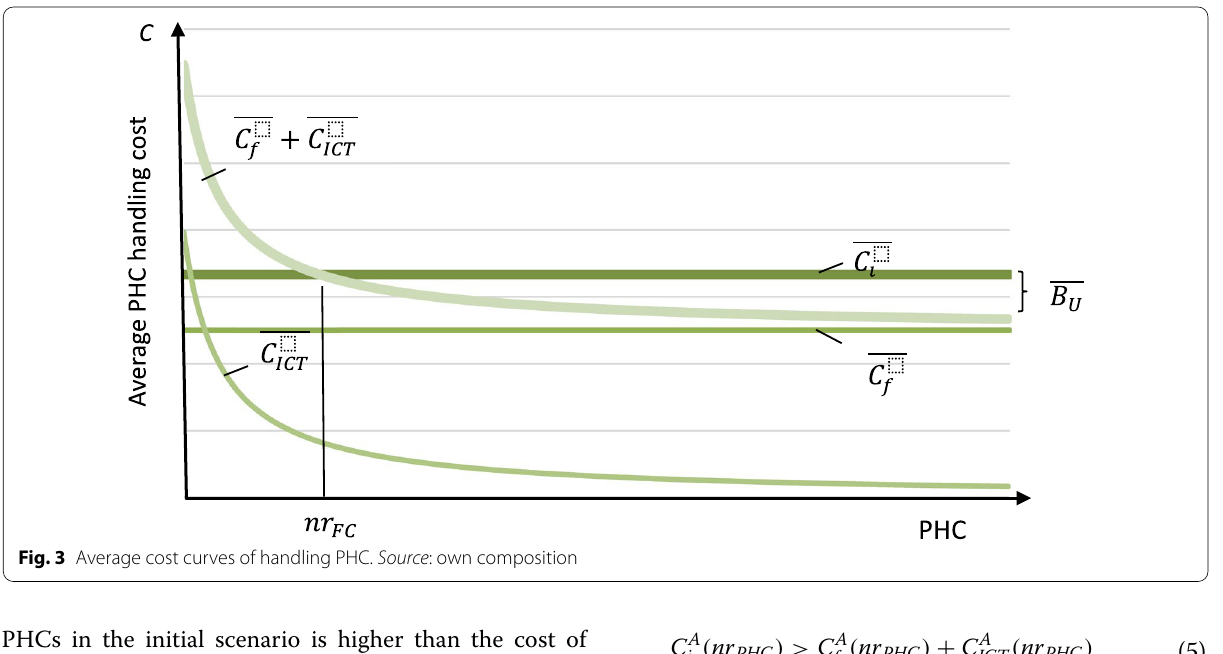
Fig. 3 Average cost curves of handling PHC. Source : own